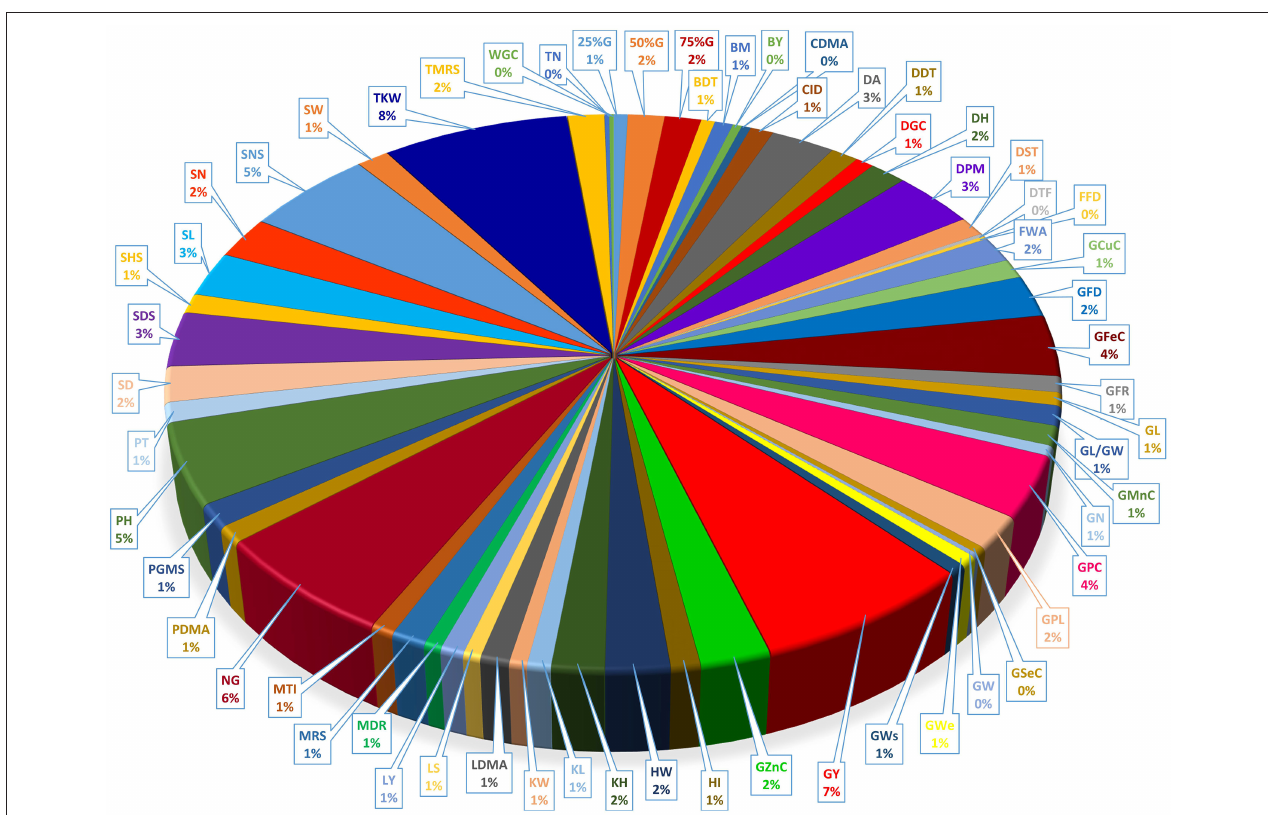
FIGURE 6 | Distribution of QTLs controlling different traits in detected MQTL regions.